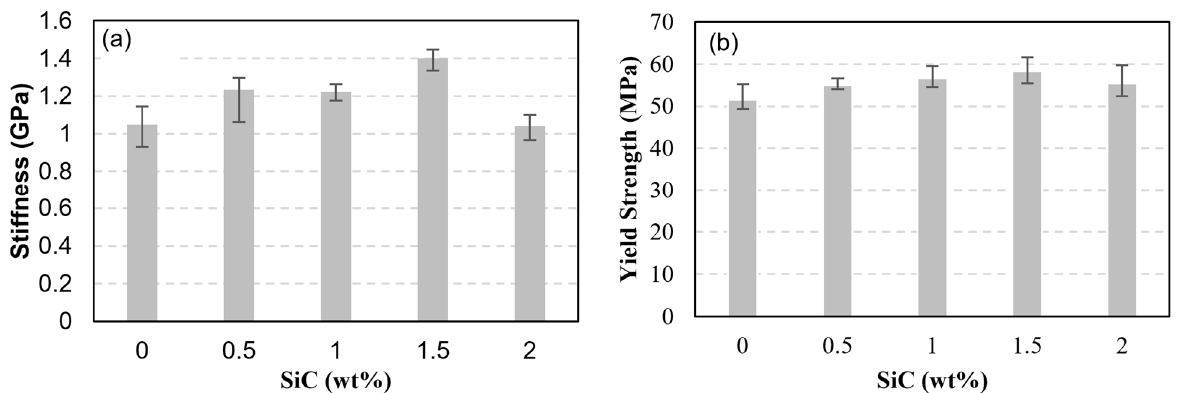
Figure 18. Properties of 3D printed PLA-SiC compression cylindrical samples, showing ( a ) stiffness and ( b ) yield strength.